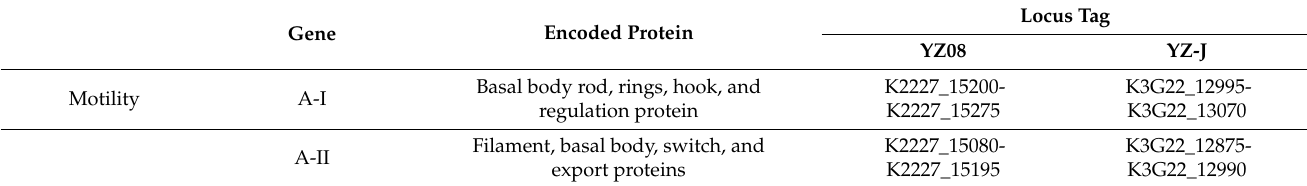
Table 2. Genes associated with motility, biogenic amine metabolism, trimethylamine metabolism, sulfur metabolism, biofilm formation, and exopolysaccharide formation in S. putrefaciens YZ08 and YZ-J.